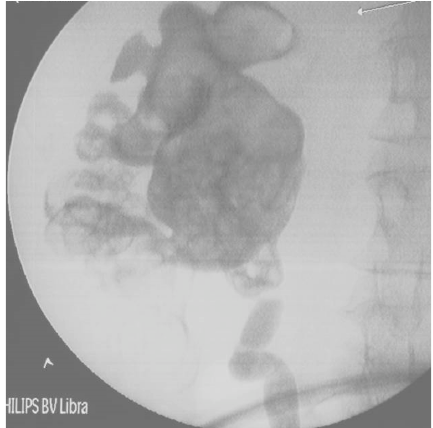
throughout. The arrow points to the site of the surgery which is the right kidney.